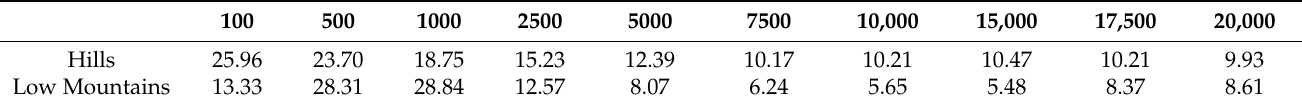
Table 4. Values of dIIC max for rainfed cropland patches under different distance thresholds.